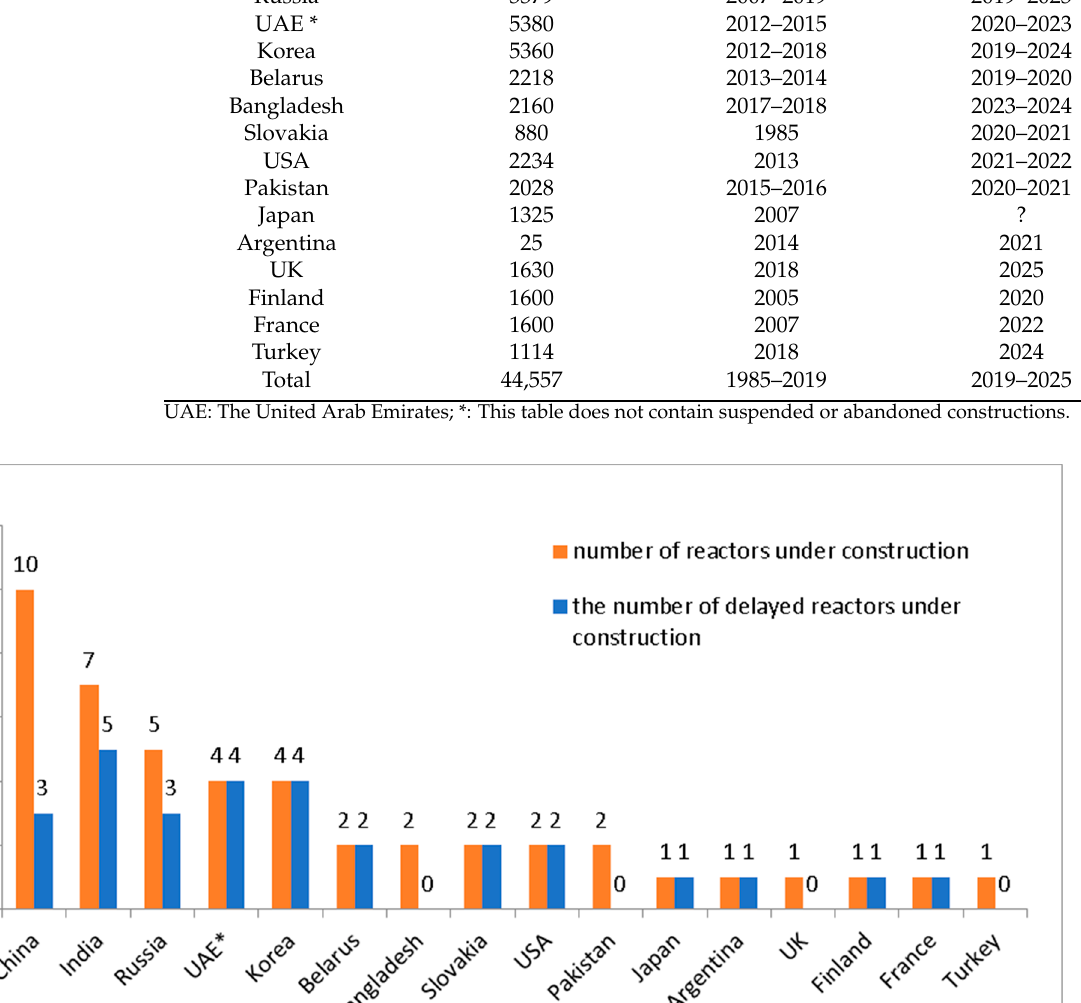
Figure 2. The structure of RES in the European Union in 2005–2030—energy produced in (TWh)—own study based on data [7,48].